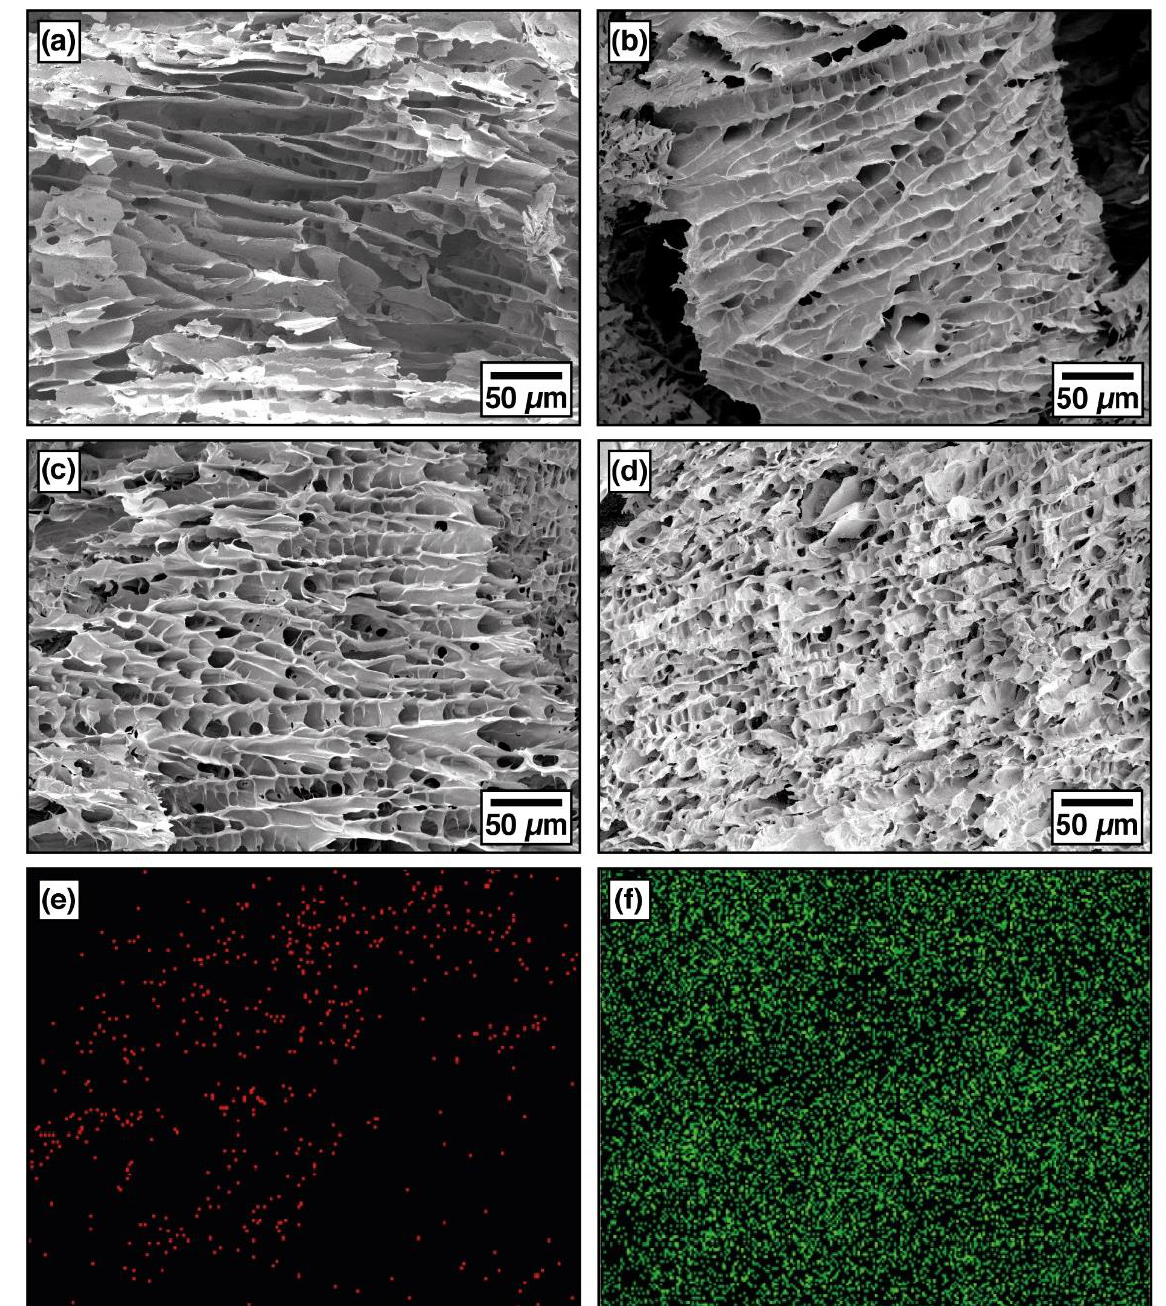
Figure 1. SEM micrographs of uncrosslinked aerogels ( a ) P5T2A1, ( b ) P5T3A2, ( c ) P5T3A3, and ( d ) P5T2A1 crosslinked aerogel; EDS images for ( e ) boron and ( f ) calcium dispersion in P5T2A1 crosslinked aerogel.